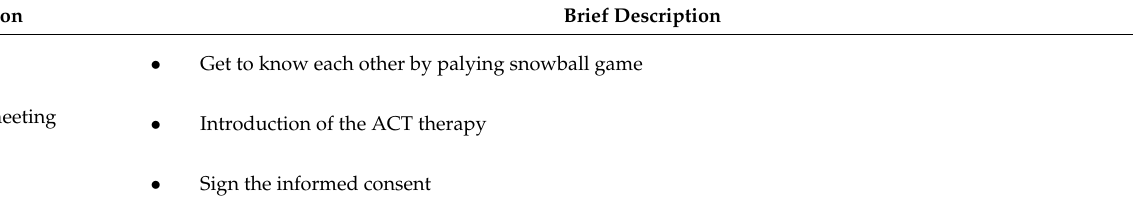
Table 2. The content of sessions based on acceptance and